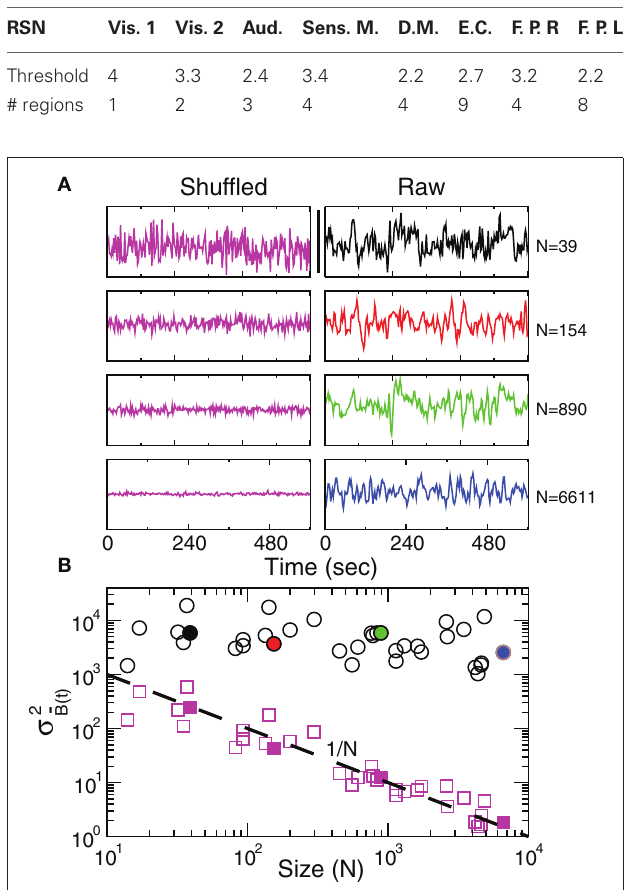
FIGURE 2 | Anomalous scaling of brain BOLD temporal fluctuations. Panel A show four examples of average BOLD time series (i.e., B ( t ) in Equation 2) computed from clusters of different sizes N . Note that while the amplitude of the raw BOLD signals (right panels) remains approximately constant, in the case of the shuffled data sets (left panels) the amplitude decreases drastically for increasing cluster sizes. Panel B shows the calculations for the 35 clusters (circles) plotted as a function of the cluster size demonstrating that variance is independent of the RSN’s cluster size. The squares symbols show similar computations for a surrogate time series constructed by randomly reordering the original BOLD time series, which exhibit the expected 1 / N scaling (dashed line). Filled symbols in Panel B are used to denote the values for the time series used as examples in Panel A .